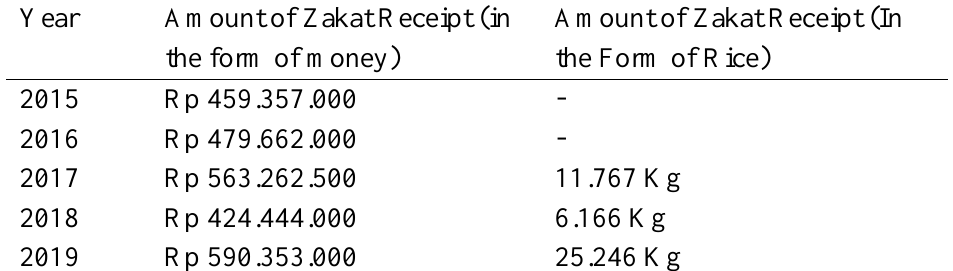
Table 1.1 Amount of Zakat Receipt in West